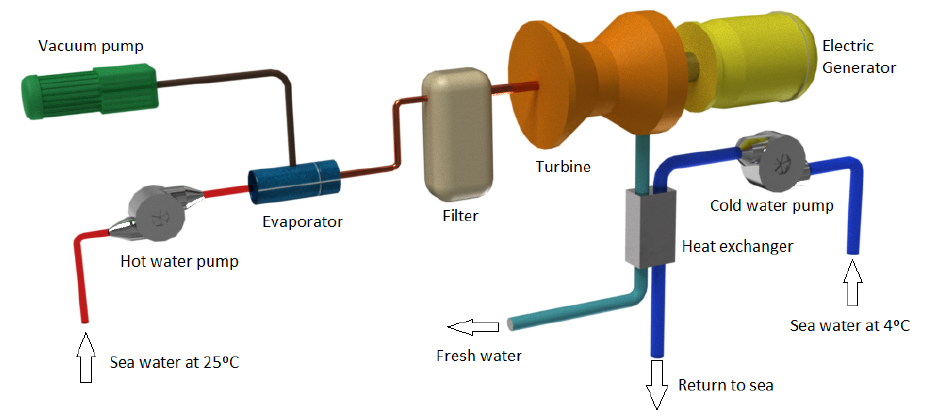
Figure 1. Open-cycle OTEC